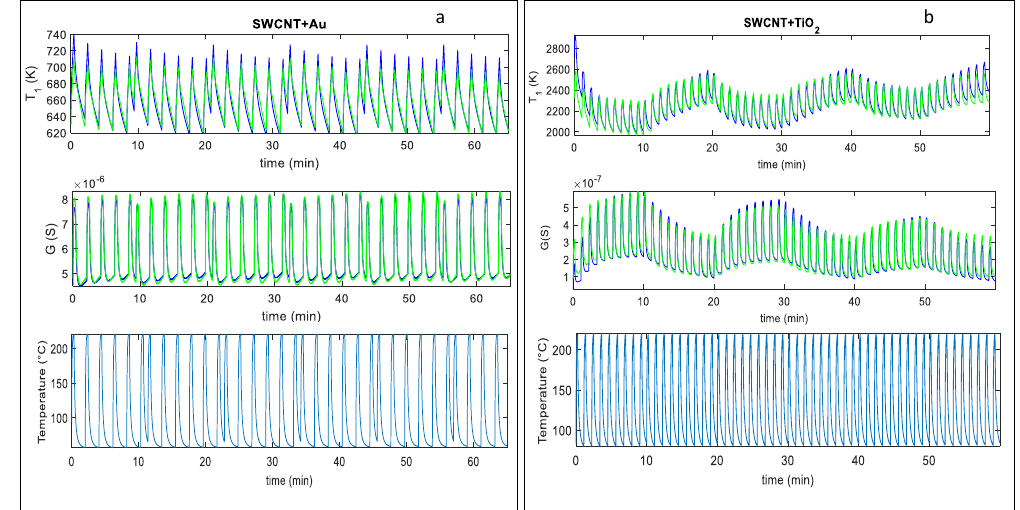
Figure 6. Fitting results obtained after parameter estimation for 𝑇 1 and G vs. time. ( a ), top two plots: Blue line-fitting results for the SWCNT-Au decorated sample, green lines-measured value; measurements obtained in a constant flow (200 mL/min) of air and 25 ppm NO 2 . ( a ), lower plot: Measured temperature profile, obtained by repeatedly heating at 220 °C for approximately 0.3 min, and at 60 °C for 1.6 min, respectively (total temperature pulse period t p ≈ 2 min). ( b ), top two plots: Blue line-fitting results obtained for the SWCNT-TiO 2 decorated sample, green lines-measured value; measurements obtained at constant flow (200 mL / min) with the following protocol: 10 min: air + 37 ppm NO 2 ; 10 min: air; 10 min: air + 25 ppm NO 2 ; 10 min: air; 10 min: air + 12 ppm NO 2 ; 10 min: air. ( b ), lower plot: Measured temperature profile, obtained by repeatedly heating at 220 ◦ C for approximately 0.2 min, and at 60 ◦ C for 0.8 min, respectively (total temperature pulse period t p ≈ 1 min).